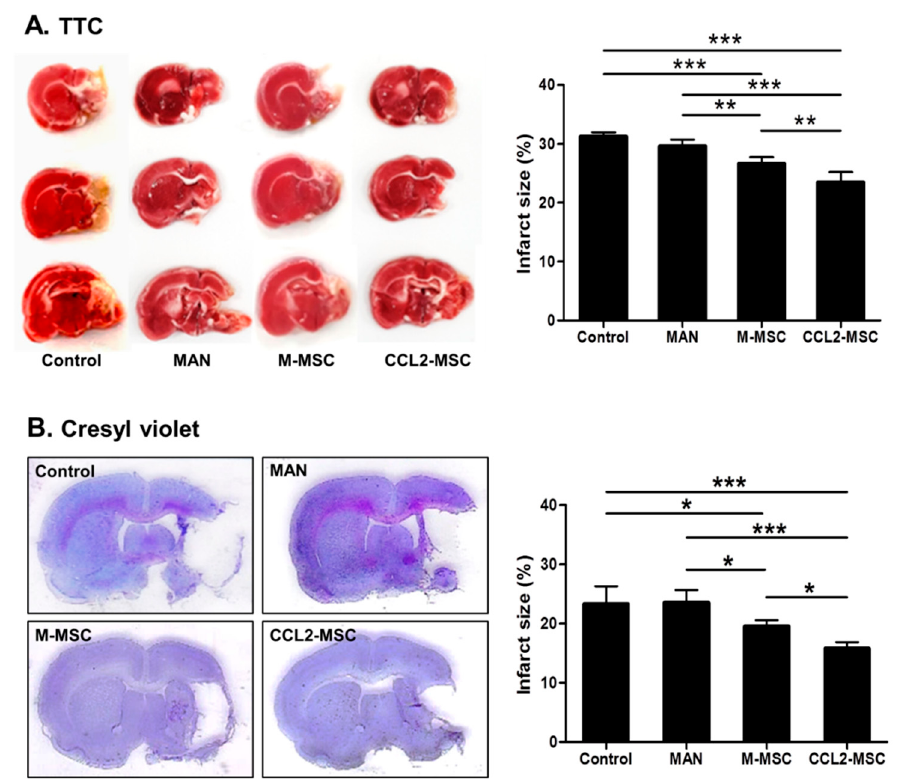
Figure 3. Comparison of infarct size between treatment groups. Infarct size was measured by ( A ) TTC and ( B ) Cresyl Violet staining at 4 weeks after MCAo induction. Data represent the mean ± SEM and were analyzed by one-way ANOVA. * p < 0.05, ** p < 0.01, *** p < 0.001.